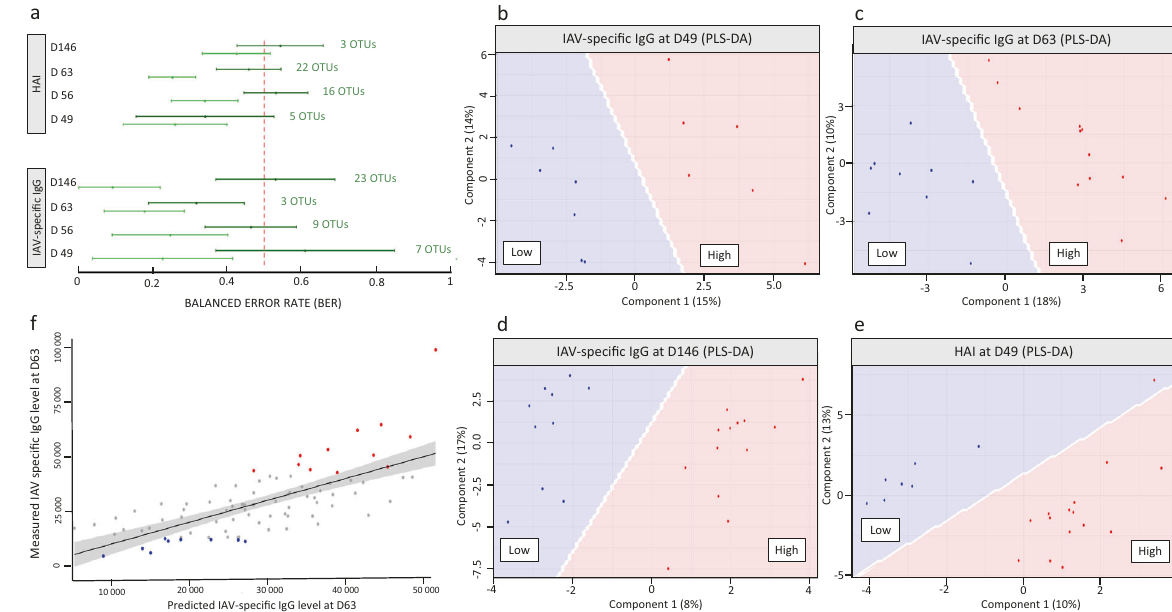
Fig. 7 Predictive capacity of OTUs in pre-vaccination D28 fecal microbiota for vaccine response measured by IAV-speci fi c IgG and HAI. a Comparison of the prediction yielded by the OTU subsets found at each time point for each vaccine response phenotype (sPLS-DA, dark green line, indication of the number of OTUs selected for each prediction) and by the combined set of 81 OTUs (PLS-DA, light green line). The BER estimations are represented by their 95% con fi dence intervals, with their means ± 2 standard deviations. b – e Projection of the groups of extreme responders to the in fl uenza vaccine as measured by IAV-speci fi c IgG at b D49, c D63, d D146, and e HAI titers at D49, obtained with a PLS-DA implemented with the combined set of 81 candidate predictive OTUs. Samples are classi fi ed as low responders (blue dots) or high responders (red dots). Corresponding sPLS-DA and PLS-DA data are available in Supplementary Table 4 and in Supplementary Data 1. f Plot of measured vs. predicted IAV-speci fi c IgG titers at D63 from a regression model. Predicted values were estimated with PLS analysis based on the counts of the combined set of 81 OTUs applied to the population of all vaccinated piglets that had both a characterized fecal microbiota at D28 and a measured titer of IAV-speci fi c IgG at D63 ( n = 86). Low vs. high responders for IAV-speci fi c IgG at D63 are represented with blue and red dots, respectively; all other animals are represented by gray